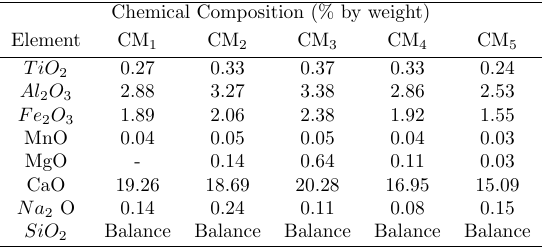
Table 1: XRF analysis of the prepared mixtures.